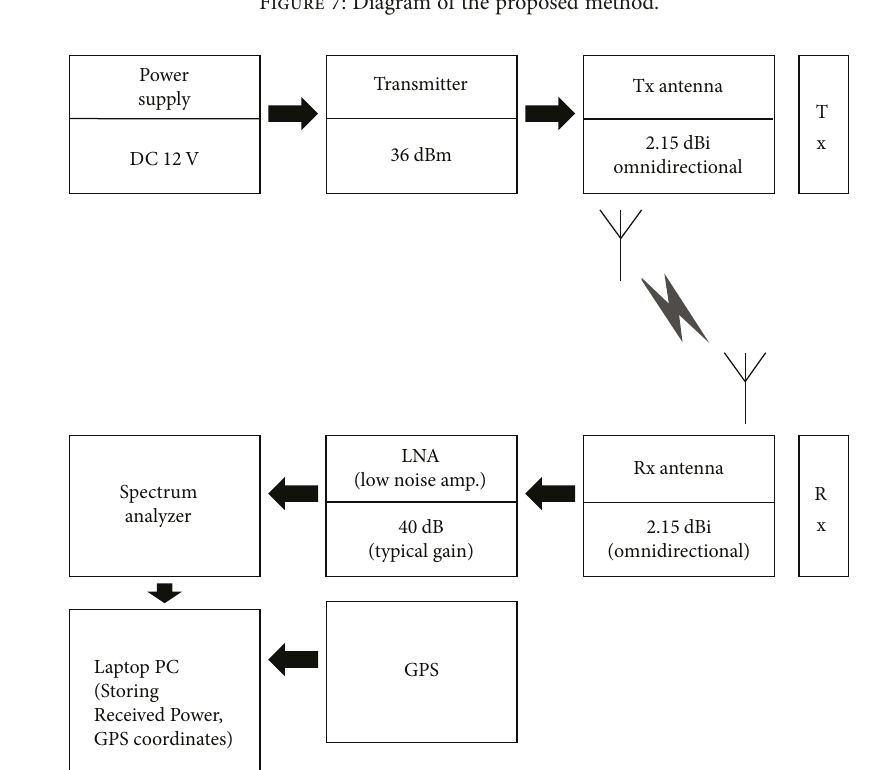
Figure 8: Measurement con fi guration